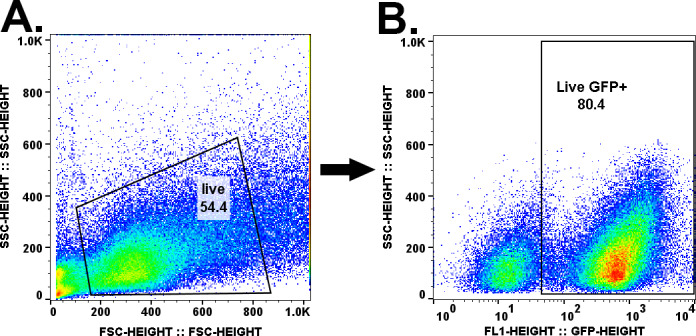
Gating strategy for flow cytometry.Droplets were dispersed into single cells after 4 hr of 0 mM DETA-NONOate treatment and subjected to flow cytometry. (A). A live gate was created to remove cellular debris. (B). Bacteria were gated for GFP+ using the gating cutoff described here and the events within this gate were analyzed for mcherry expression. The same gates were applied to all samples presented in Figure 6 and Figure 8.